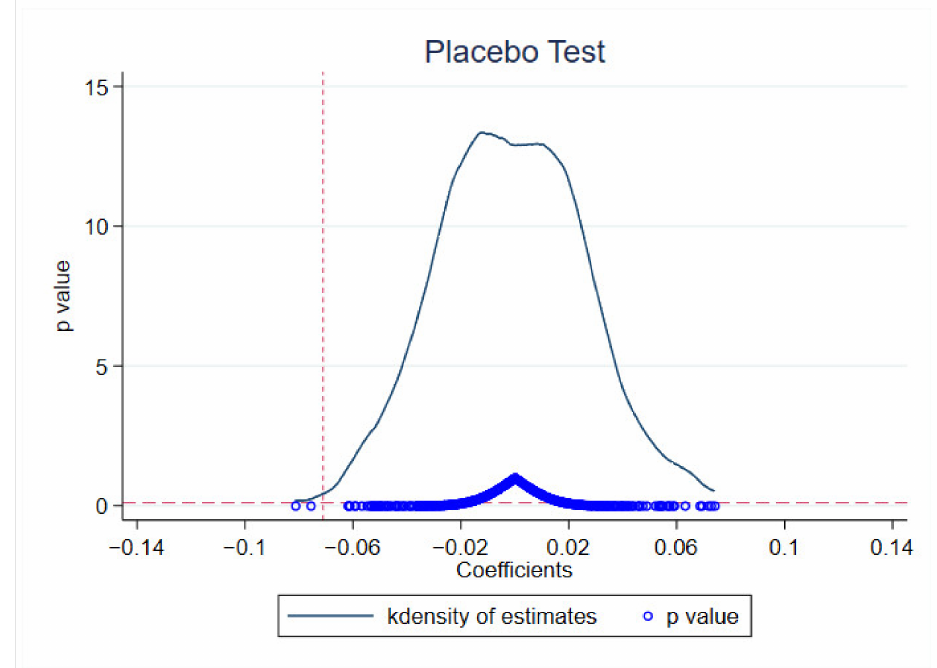
Figure 4. Placebo test.